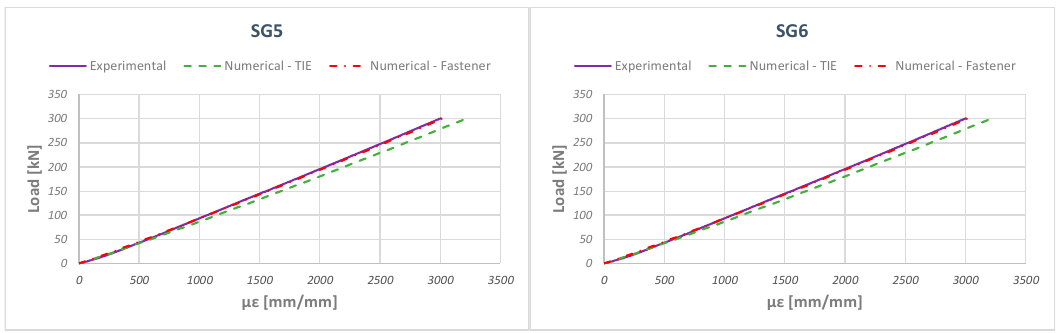
Figure 14. Numerical–experimental comparisons for SG-5 and SG-6: numerical TIE and Fasteners models.